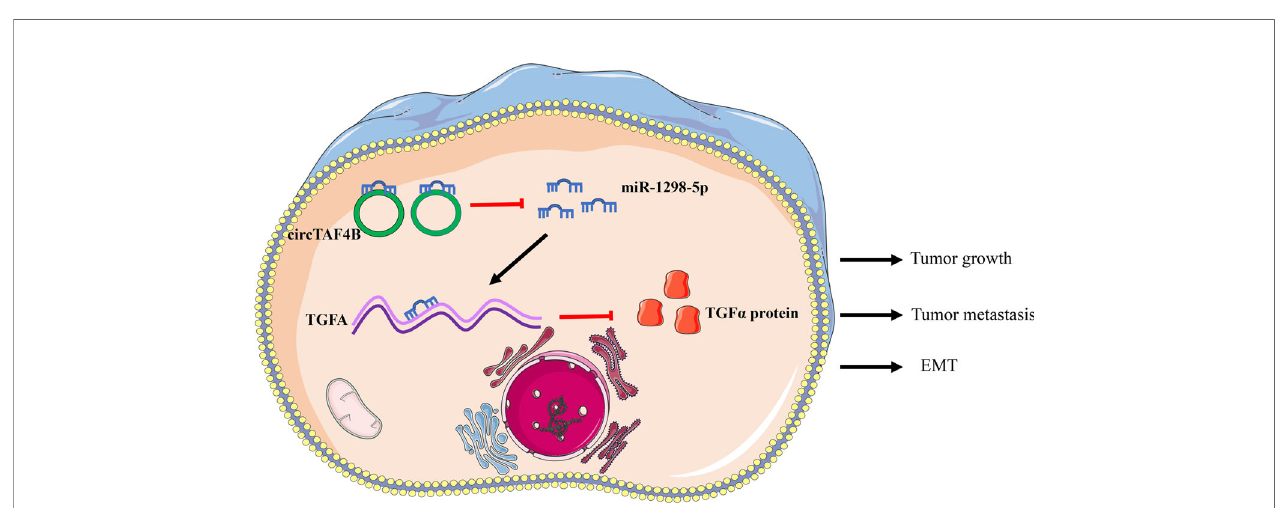
FIGURE 8 | Schematic diagram of the circTAF4B/miR-1298-5p/TGFA axis in the progression of BCa.